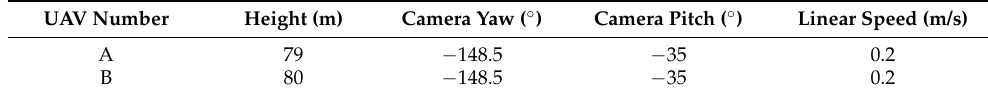
Table 1. The flight parameters of two